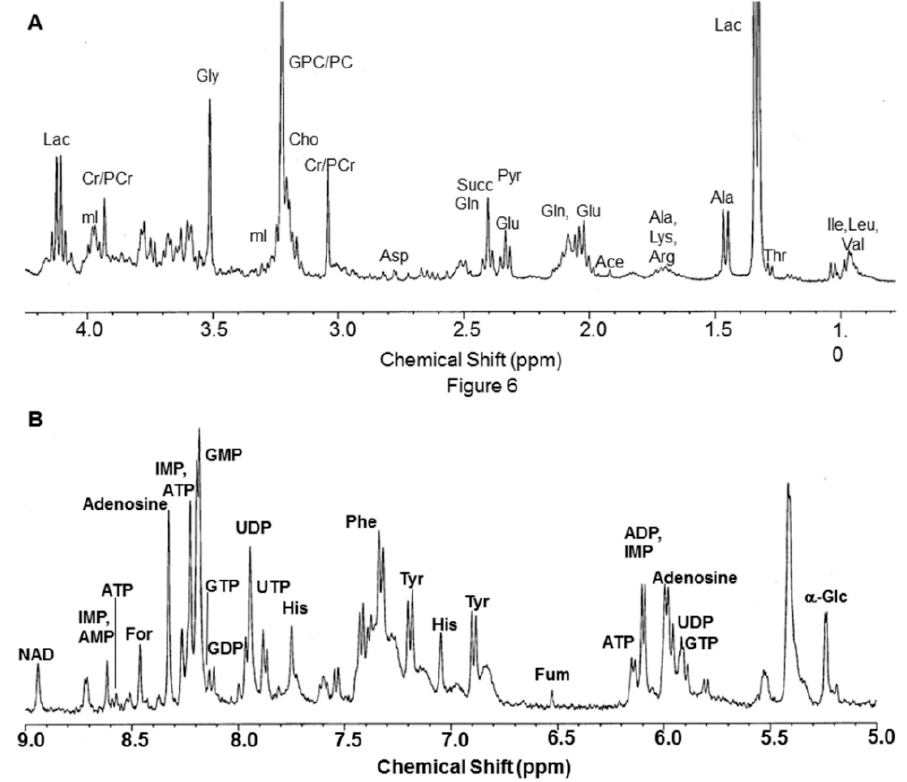
Figure 3. ( A ) 1D 1 H NMR spectrum region showing the metabolite resonances from 0.8 to 4.2 ppm recorded at 400 MHz of perchloric acid extract (pH 7) of involved axillary lymph node of a breast cancer patient. Pyr = pyruvate; Arg = arginine; Gly = glycine. ( B ) The expanded region showing the metabolite resonances from 5 to 9 ppm of the same patient. NAD = nicotinamide adenine dinucleotide; IMP = inosine monophosphate; GMP = guanosine monophosphate; GTP = guanosine triphosphate; GDP = guanosine diphosphate; UDP = uridine diphosphate; Tyr = tyrosine (Reproduced with permission from Elsevier from Reference